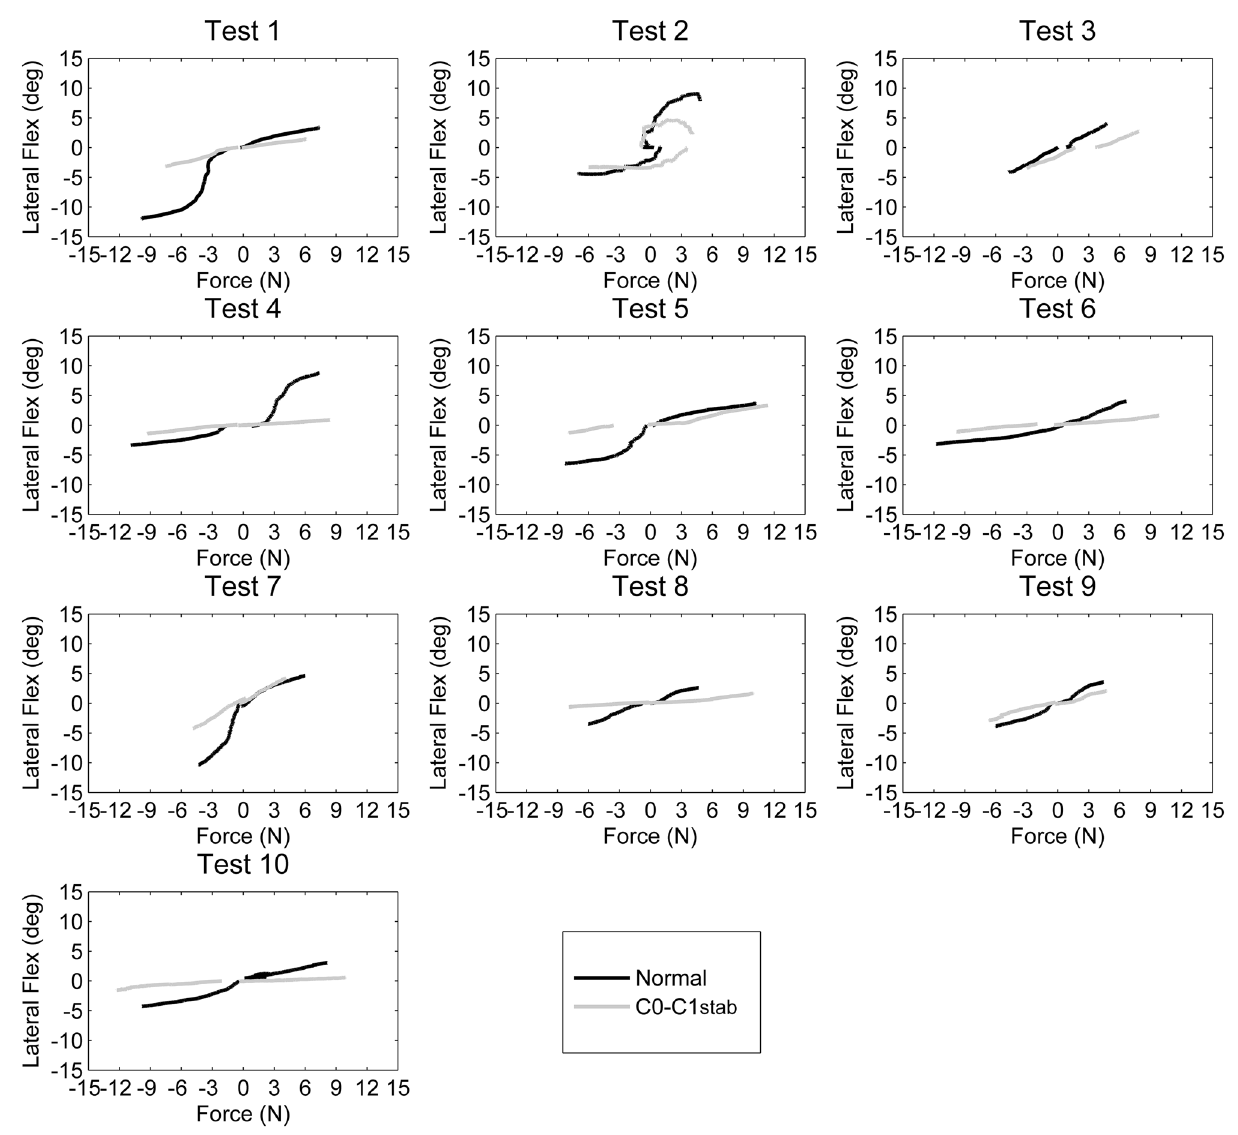
Figure 4. Forces required for left (negative values) and right lateral flexion (positive values) during the full range of motion in the 10 specimens: normal and with C0–C1